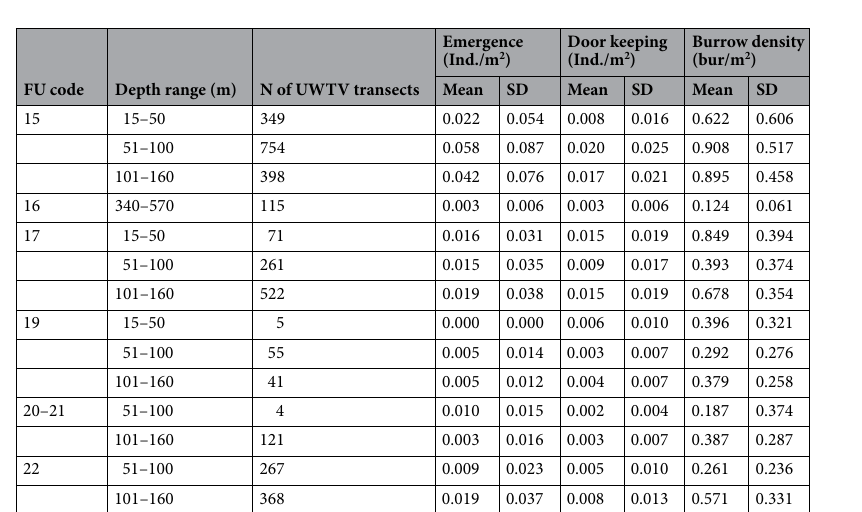
Figure 4. Integrated chart showing temporal relationships among peaks timings, as derived from plots of waveform and GAM analyses (i.e. phases as values above horizontal threshold lines; see Figs. 2 and 3). According to GAMs, the best timings of UWTV surveying where highest (maximum) number of animals can be observed, are indicated with the letter M and grouped by blue rectangles.